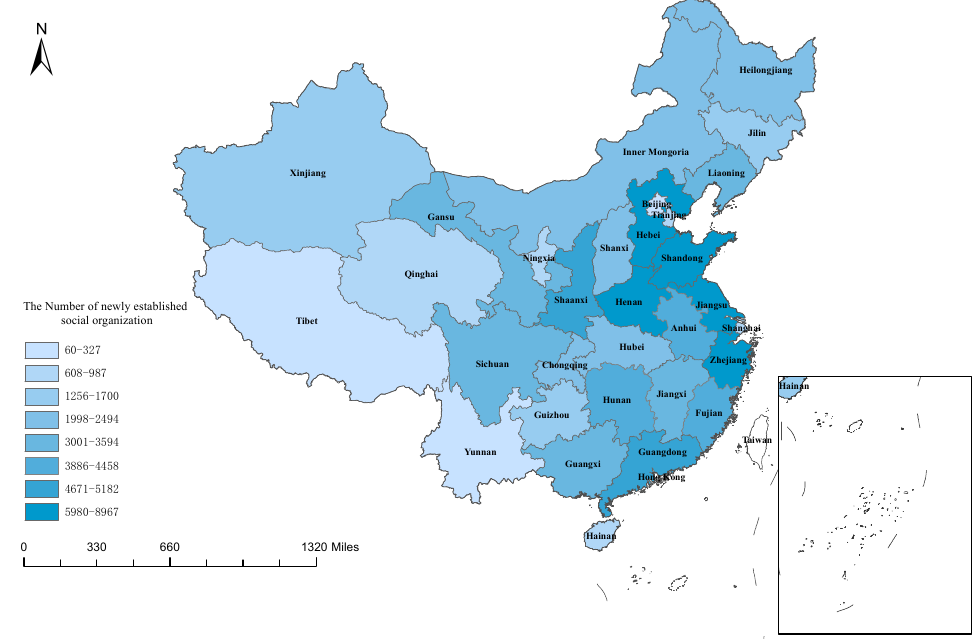
Figure 11. The number of newly established social organizations between August 2020 and August